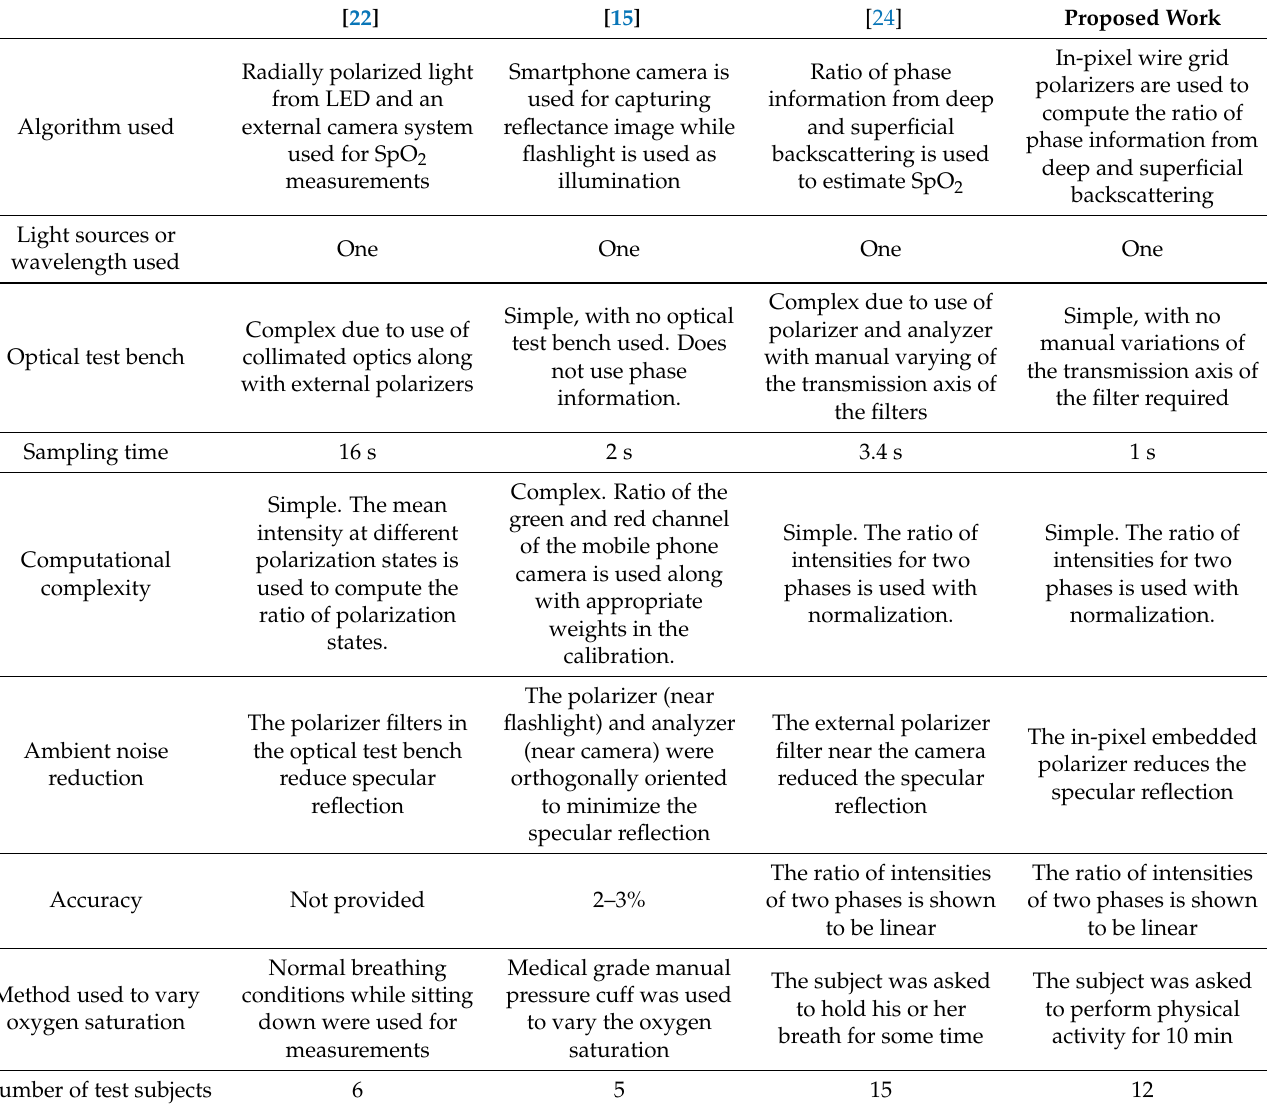
Table 2. Comparison with the state of the